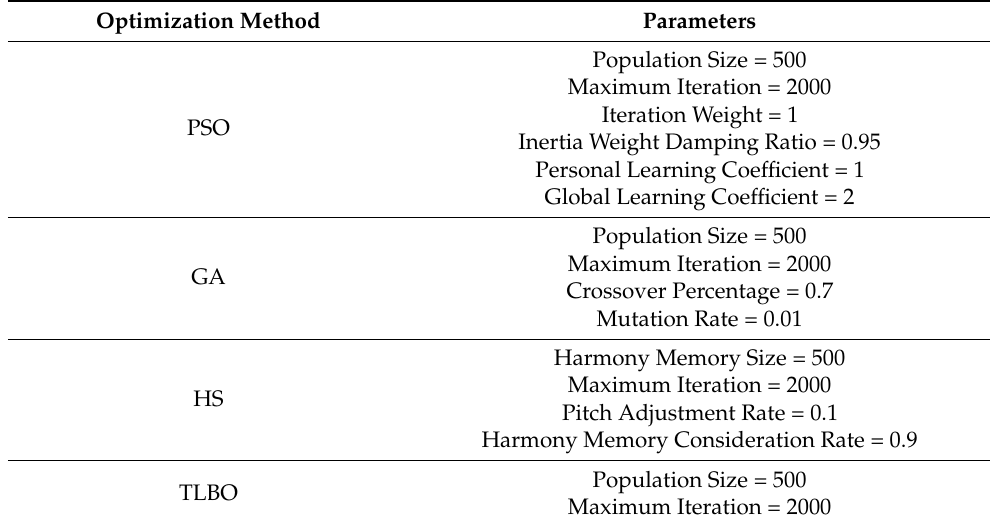
Table 4. The parameter values of the four meta-heuristic algorithms used in this study. Optimization